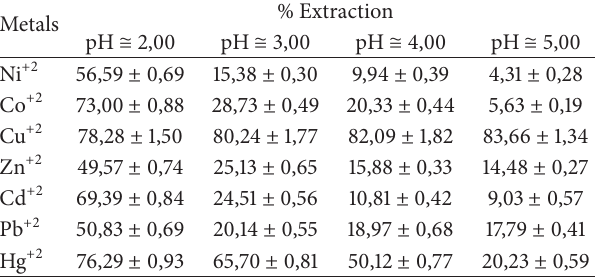
Table 4: Extraction of metal cations with L3 (%).